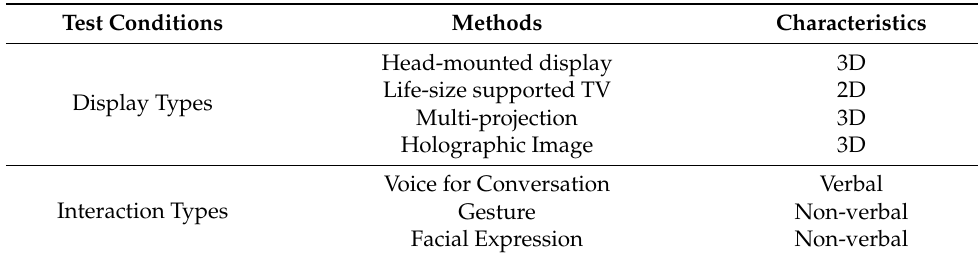
Table 1. Candidate test conditions in our experiment in terms of display and interaction